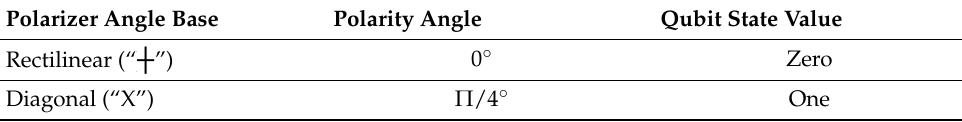
Table 5. Photon polarization encoding scheme for BB92. Table 3. BB84 qubit SOP-based encrypting design.